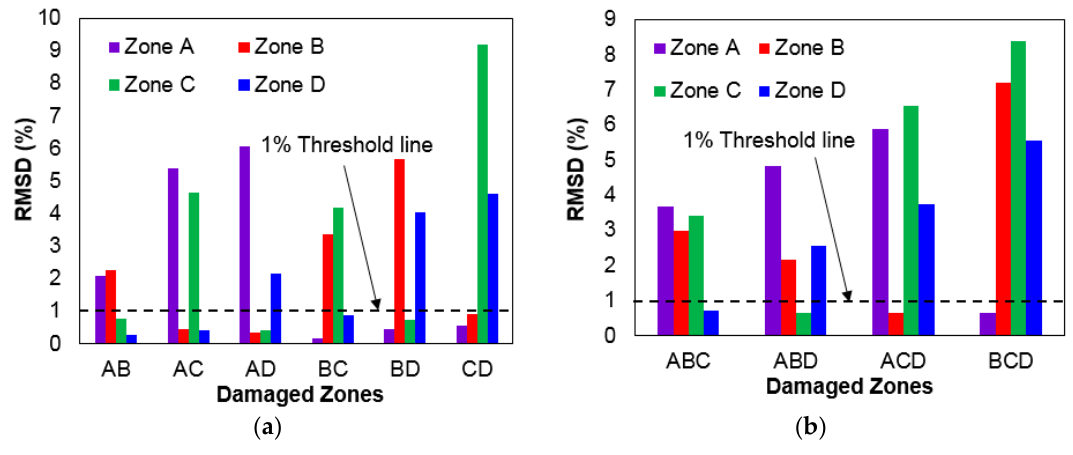
Figure 8. Bar graphs of RMSD values from impedance signatures from: ( a ) Case 7; ( b ) Case 8.